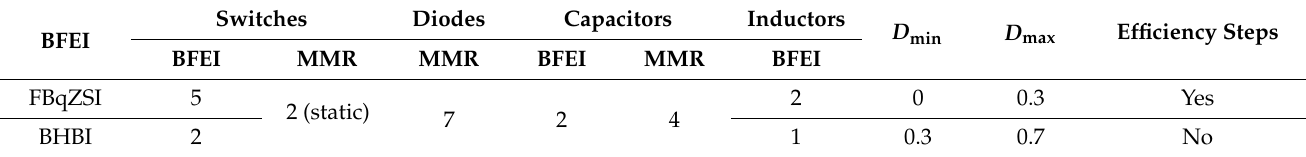
Table 2. Comparison of the two implementations of the converter with the